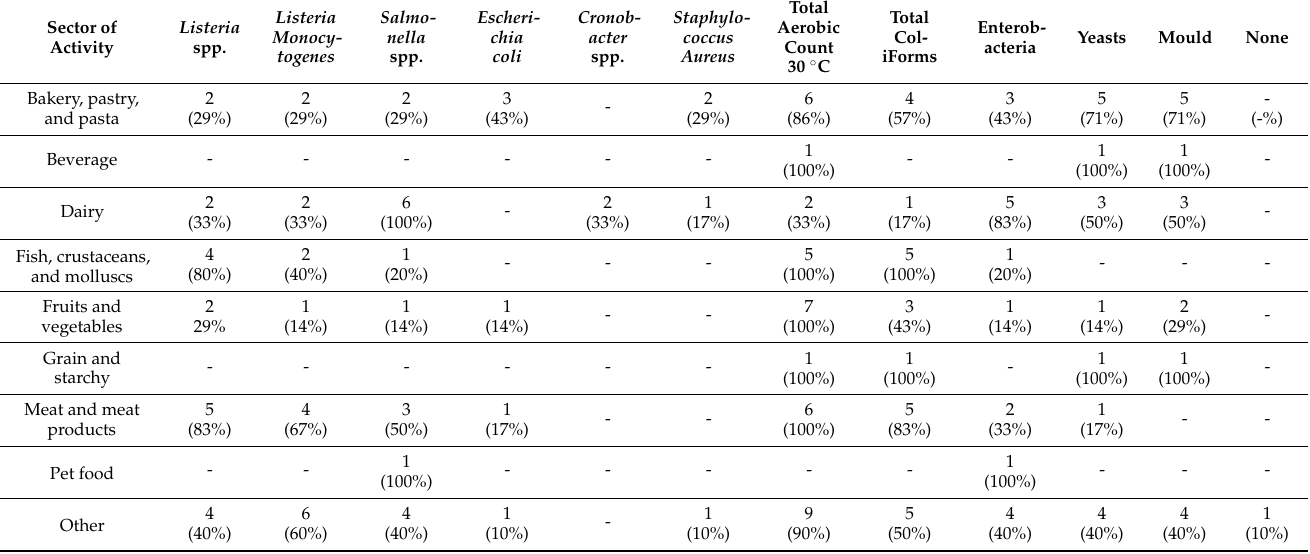
Table 1. Recurrence of monitoring microorganisms or groups of microorganisms within the frame- work of the Environmental Monitoring Programs by the French agri-food industries surveyed. The same agri-food industry corresponds to several food sectors. The results are expressed as the number of agri-food industries that responded to monitoring the hazard, and the values in brackets corre- spond to the percentage of agri-food industries within the same food sector concerned by the hazard being